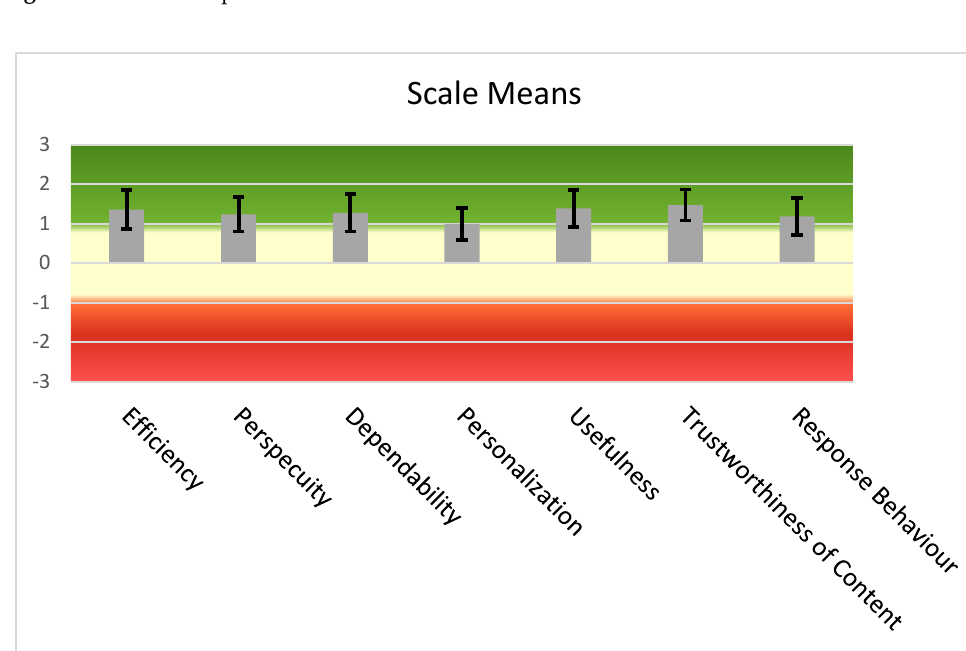
Figure 10. Scale Means and Standard Deviation. Next, the above scales are then analyzed into their constituent items, four per scale, in order to highlight, in greater detail, the above observations. The order of the exposition for the individual items mirrors the order the scales are presented. For the scale of Efficiency (1.36), users judged that the application was found to be primarily very organized (1.53), practical (1.33), fast (1.30) and that it was very efficient (1.27). Users stated that they do not have to perform unnecessary actions and they do not have to wait too long for the application to